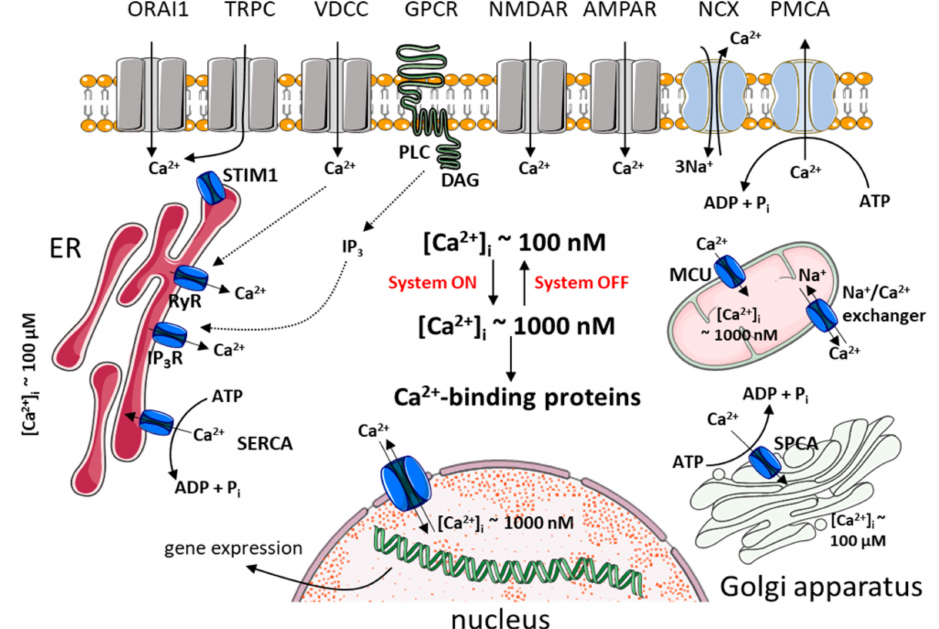
Figure 2. Calcium homeostasis and signaling in healthy neurons. Ca 2 + can enter the cell during the “on” phase through voltage-dependent calcium channels (VDCCs), transient receptor potential channels (TRPCs), calciumrelease-activatedcalciumchannel(ORAI1)orthroughglutamate-activatedreceptor-operatedchannels: N-methyl-D-aspartate receptors (NMDARs) and α -amino-3-hydroxy-5-methylisoxazole-4-propionate acid receptors (AMPARs). Calcium can be mobilized from the ER upon activation of some G protein-coupled receptors (GPCRs) via inositol-1,4,5-triphosphate (IP 3 ) receptors (IP 3 Rs) or its release may occur through ryanodine receptors (RyRs). Depletion of the ER is followed by the activation of store-operated calcium entry (SOCE) which is based on the interaction between ORAI1 and the stromal interaction molecule 1 (STIM1). Intracellular Ca 2 + increases are buffered by calcium-binding proteins but some Ca 2 + signals can reach the nucleus and affect gene transcription. During the “off” phase, cytosolic Ca 2 + is sequestered by sarco(endo)plasmic reticulum Ca 2 + -ATPase (SERCA), secretory pathway Ca 2 + -ATPase (SPCA) or mitochondrial uniporter (MCU) to the ER, Golgi apparatus and mitochondria, respectively, or transported to the extracellular milieu by plasma membrane Ca 2 + -ATPase (PMCA) and Na + / Ca 2 + exchanger (NCX). Ca 2 + in the nucleus is controlled